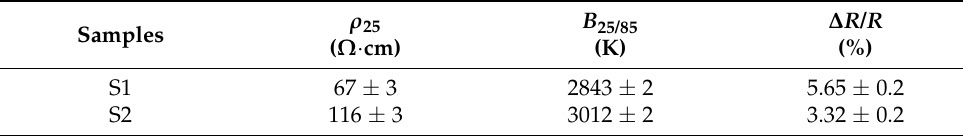
Table 4. Electrical properties of sintered ceramics.